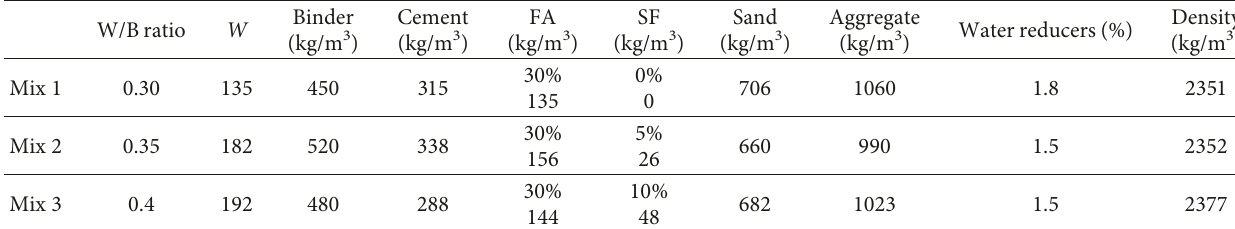
Table 3: Mixture